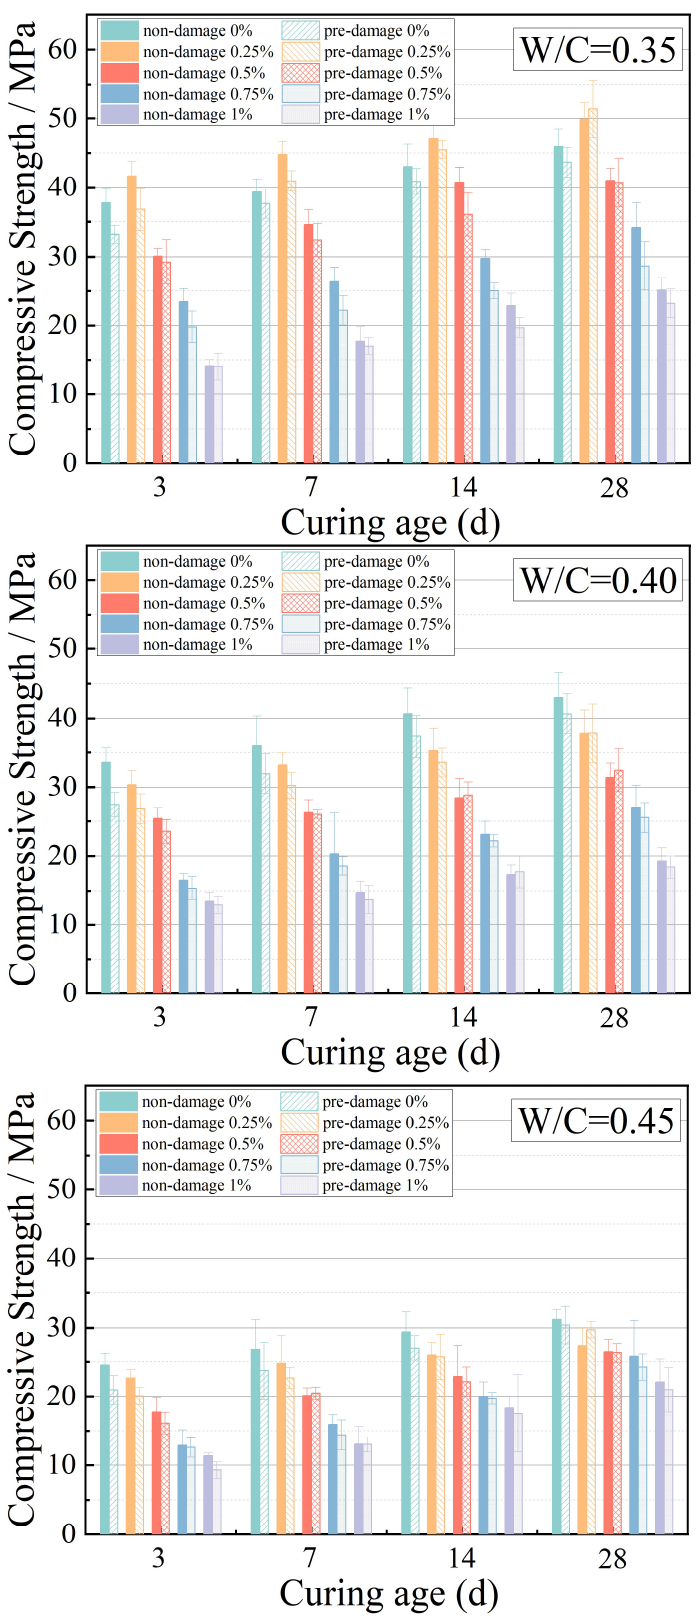
Figure 4. Unconfined compressive strengths of samples in non-damage and pre-damage states at different W/C ratios (0.35, 0.4, and 0.45), ages (3 d, 7 d, 14 d, and 28 d), and SAP components (0%, 0.25%, 0.5%, 0.75%, and 1%).